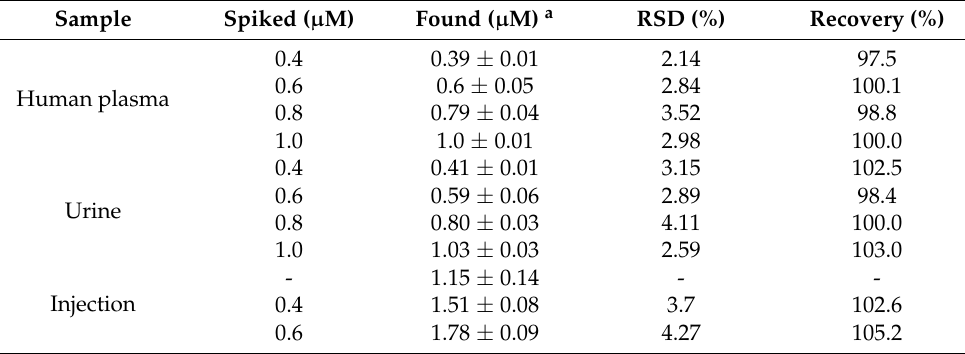
Table 3. Analysis of EPR in real samples using Au@NiFe 2 O 4